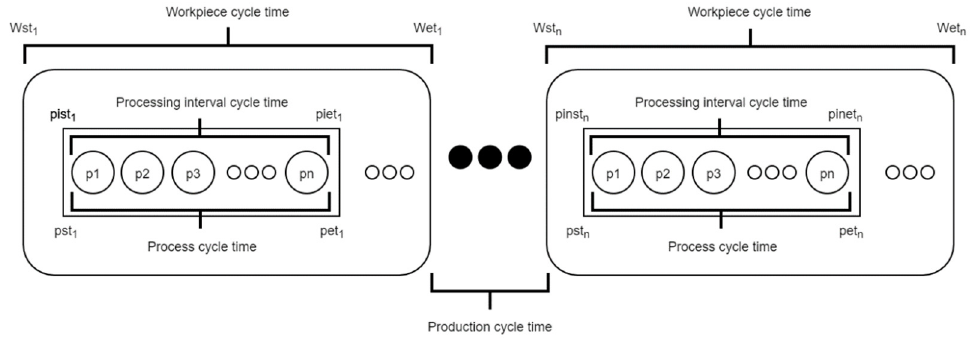
Figure 3. Process of